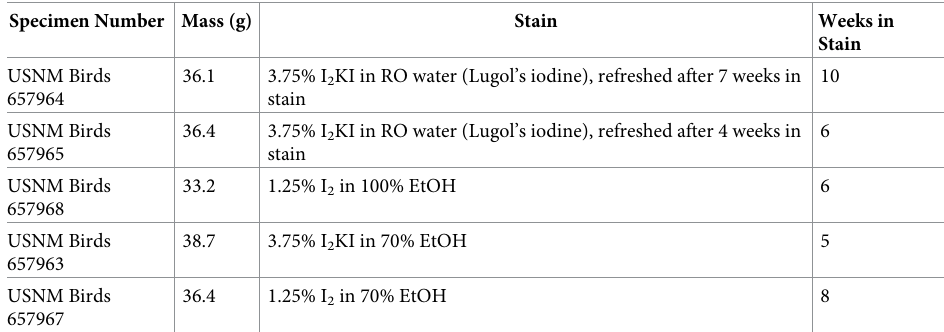
Table 1. Stain type and staining duration. Specimen Number Mass (g) Stain Weeks in